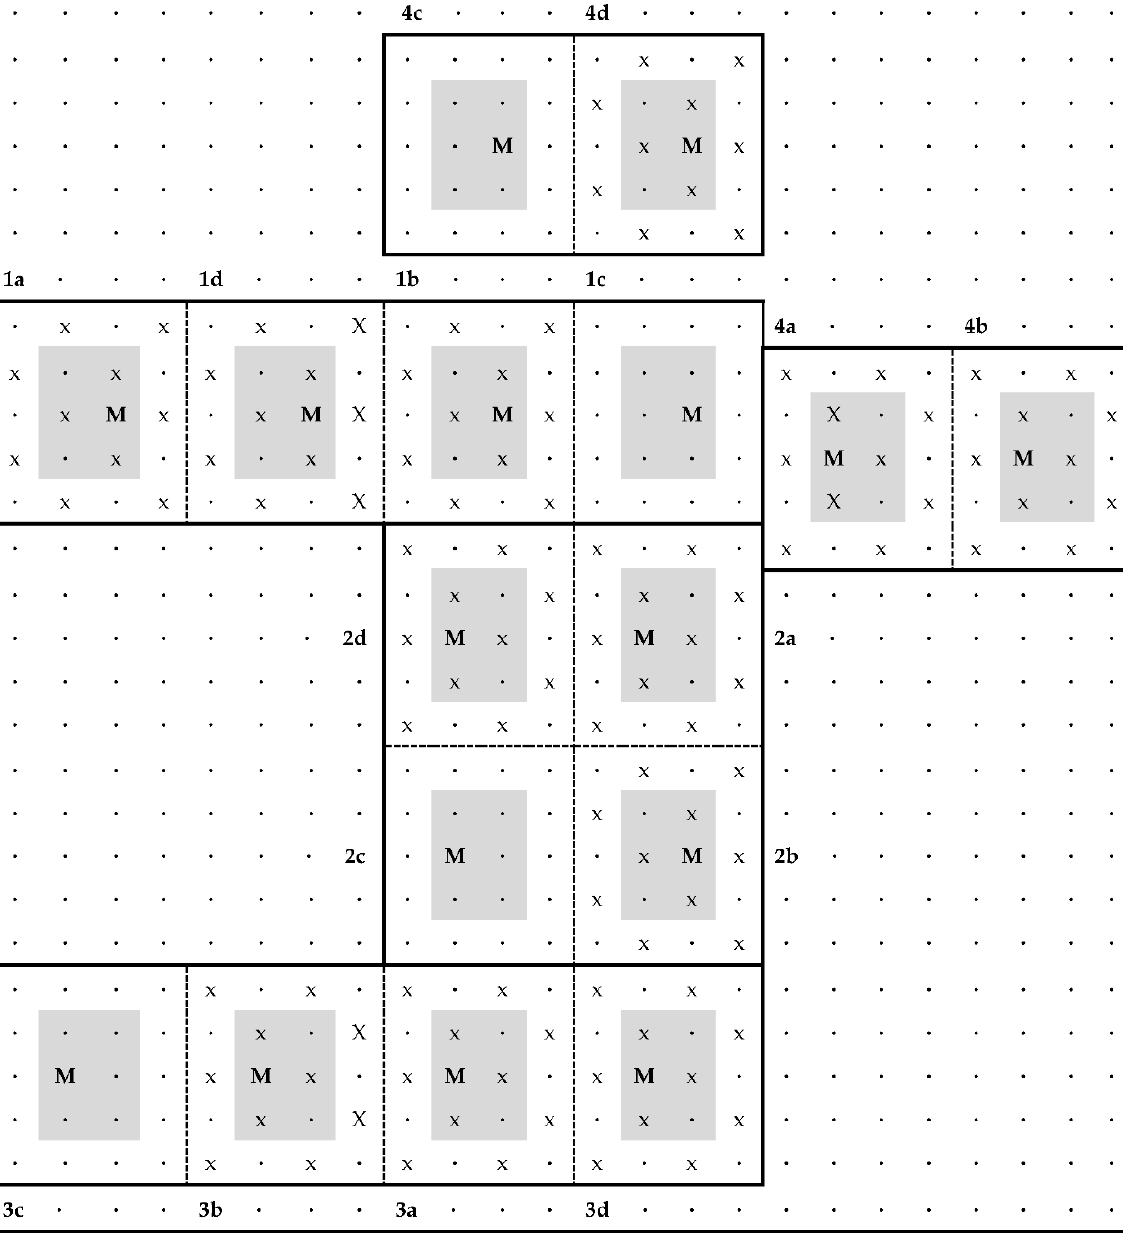
Figure 2. Experimental design of the olive fly mass-trapping system comparison trial within the experimental table olive orchard. Each small square has a 6 × 6 m dimension and an olive tree in the centre. Solid lines show the dimensions and positions of the 4 replicate blocks within the orchard. The four treatment plots within each replicate block are separated by dotted lines and labelled with lower case letter ( a , Eco-Trap; b, Pepito trap; c , no trap control; d , Elkofon-1500 traps). An individual mass-trapping device was positioned in the canopy of every 2nd tree, and trees with a mass-trapping device are shown as x, while trees without a mass-trapping device are shown as λ ; trees in which McPhail traps were placed to monitor olive fly activity are shown as M . The six trees in each treatment plot from which olive fruit samples for olive fly infestation assessment were collected are shown as grey shaded areas.